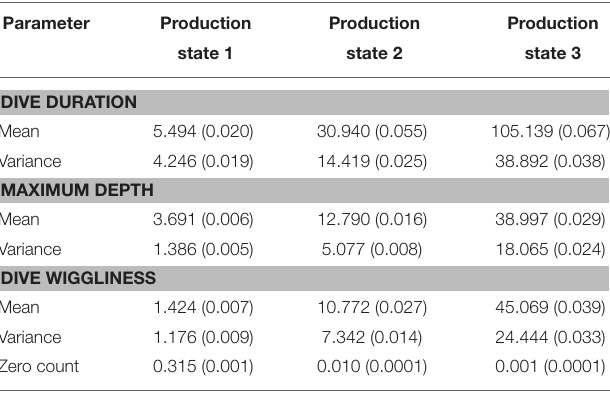
TABLE 3 | Parameter estimates for the hyperparameters obtained through the MH algorithm with parallel tempering using seven